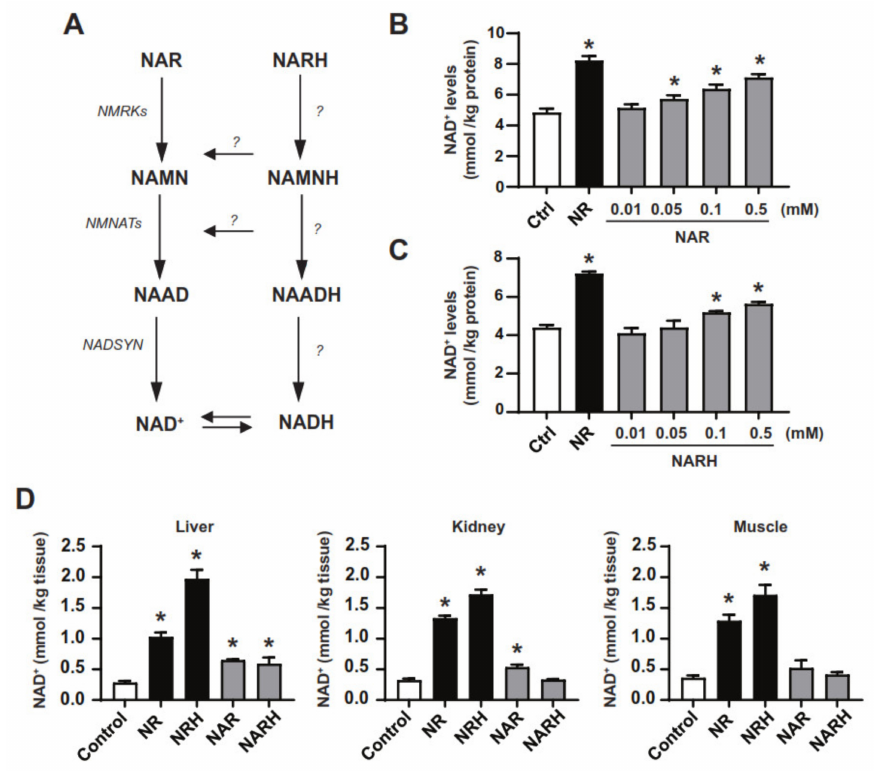
Figure 2. NAR and NARH as NAD + precursors. ( A ) Potential NAD + synthetic routes from NAR and NARH. ( B ) AML12 were treated in a dose-response fashion with PBS (as control), NR (0.5 mM) or increasing concentrations of NAR for 1 h. Then, acidic extracts were obtained to evaluate NAD + levels. ( C ) AML12 were treated in a dose-response manner with PBS (as control), NR (0.5 mM) or increasing concentrations of NARH for 1 h. Then, acidic extracts were obtained to evaluate NAD + levels. ( D ) Mice, n = 4–6 per group, were fasted for 2 h and administered intraperitoneally with saline (as control) or 500 mg/kg of NR, NRH, NAR or NARH. Then, 1 h later, liver, kidney, and quadriceps muscle were collected and flash-frozen to evaluate NAD + levels. All values are presented as mean ± SEM of n = 6 independent experiments ( B , C ) or n = 4 animals per group ( D ). * Indicates p < 0.05 vs. the control